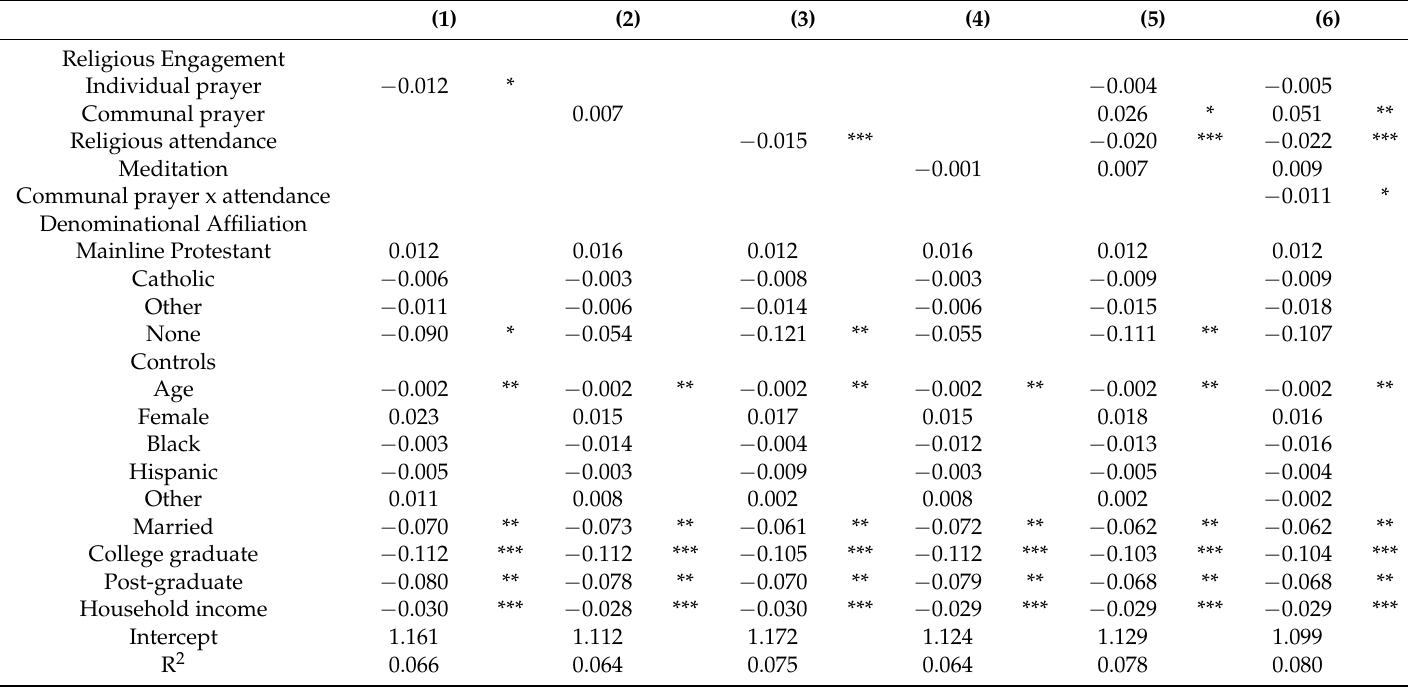
Table 2. OLS Regression Models Estimating Past-Month Symptoms of Anxiety ( n =